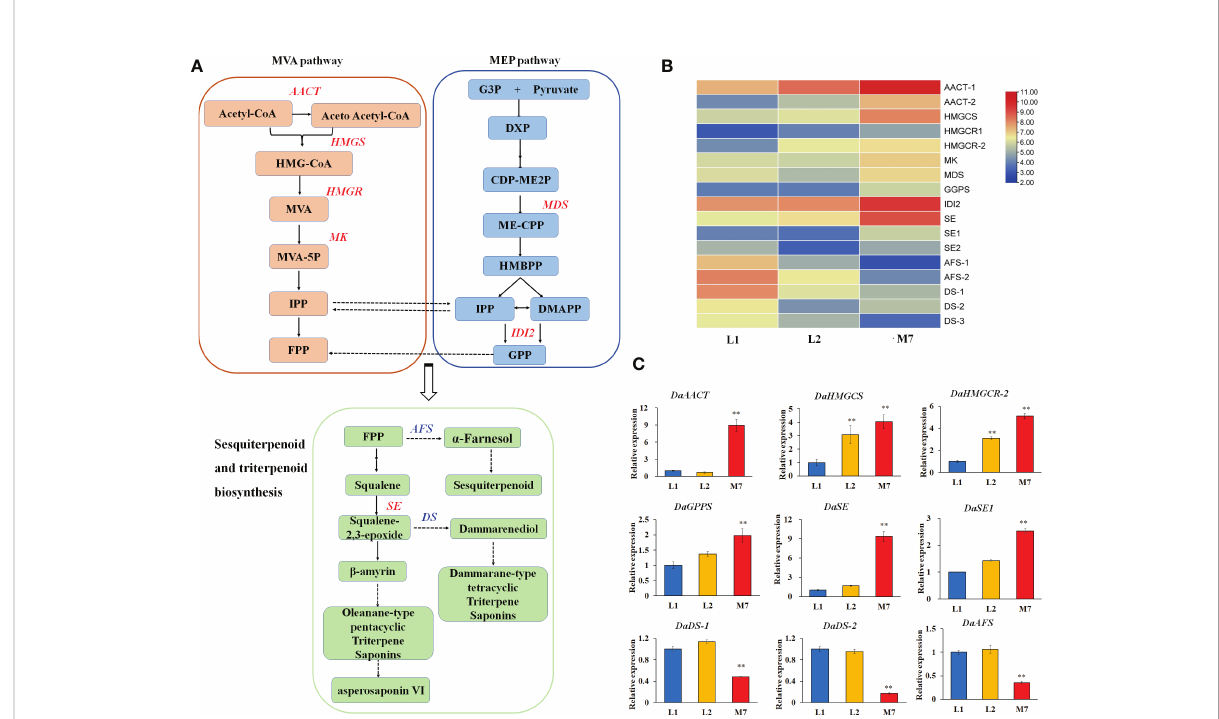
FIGURE 5 The biosynthesis of sesquiterpenoid and triterpenoid at different developmental stages. (A) The biosynthesis pathway of sesquiterpenoid and triterpenoid was produced according to the KEGG database. (B) The heat map of genes associated with terpenoid backbone, sesquiterpenoid and triterpenoid biosynthesis based on their expression level. (C) The expression of DaAACT, DaHMGCS, DaHMGCR, DaGPPS, DaSE, DaSE1, DaDS-1,DaDS-2, DaAFS in the pathway of A during root development. The values are the means ± SD; n = 3. Statistical analyses were performed using Student ’ s t test compared with L1. **, P < 0.01. AACT, Acetyl-CoA acetyltransferase; SE, squalene epoxidase; DS, dammarenediol synthase; AFS, alpha-farnesene